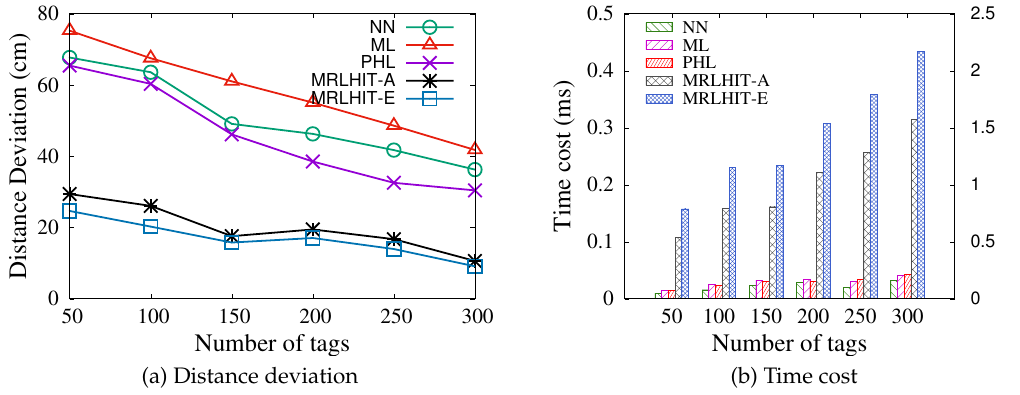
Figure 8. Varying the number of tags detected simultaneously with δ d = 20 cm, δ s = 3, grid _ size = 60